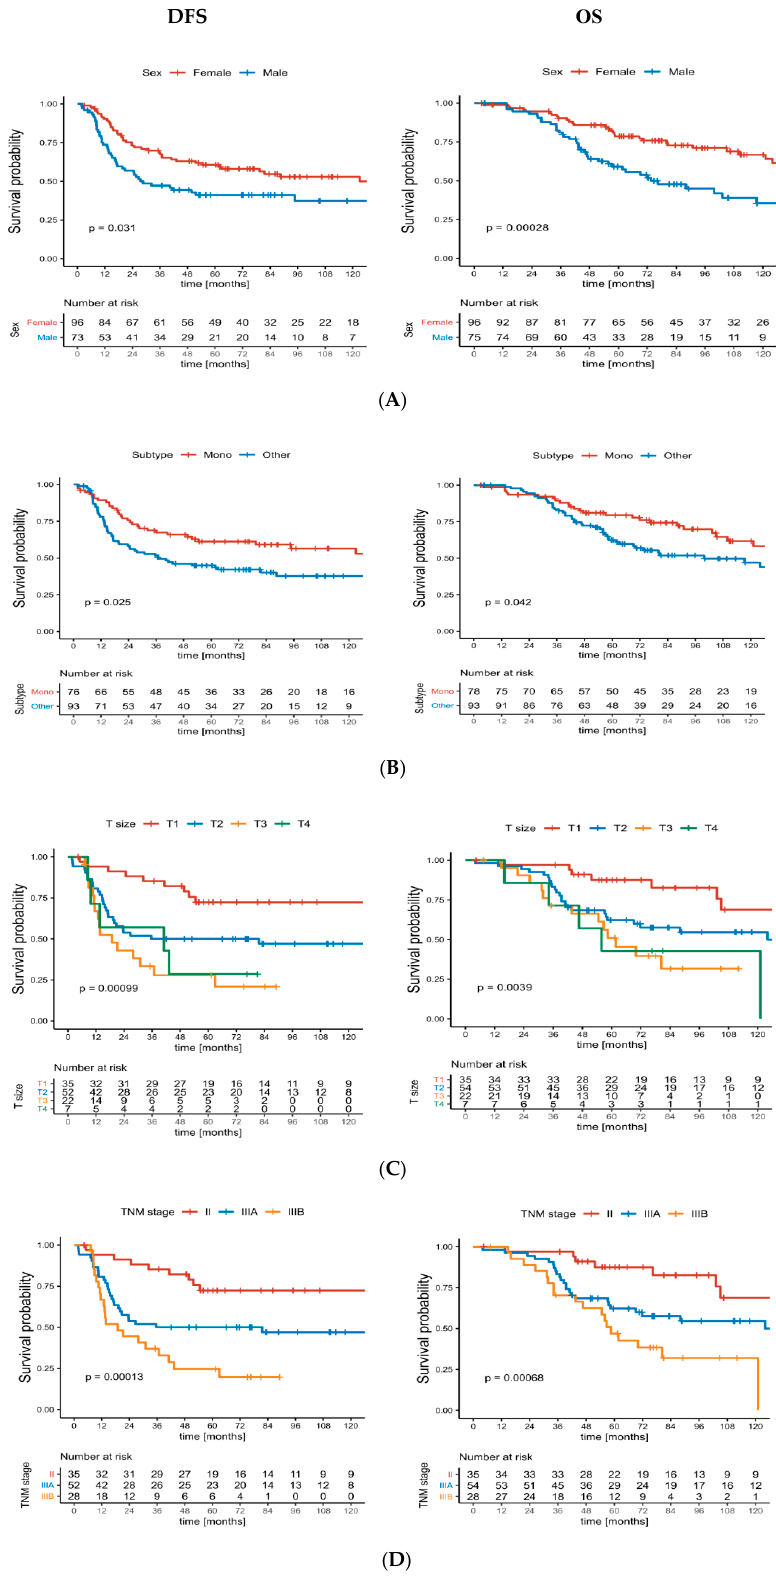
Figure 1. The curves of disease-free survival (DFS) and overall survival (OS) according to ( A ) sex, ( B ) histological subtype, ( C ) T stage and ( D ) TNM (tumour, node, metastasis) stage in patients with localised synovial sarcoma.